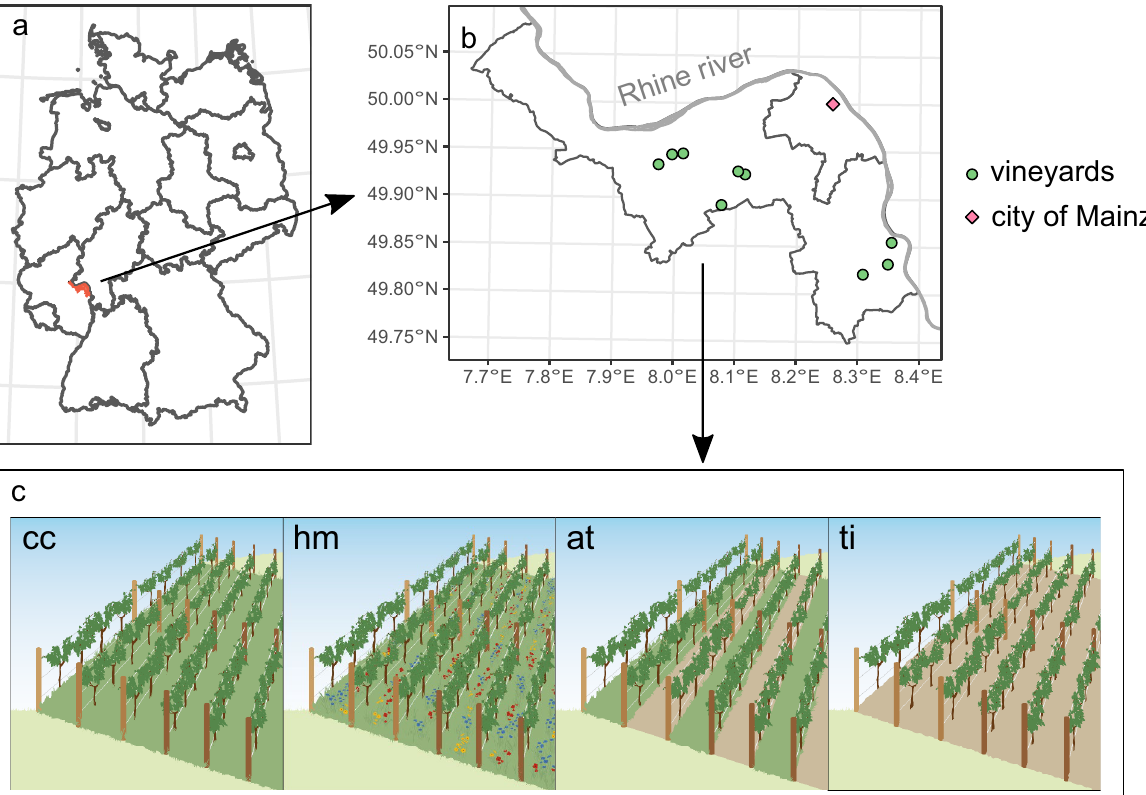
Figure 1. Location of experimental vineyards ( a , b ) and design of treatments ( c ). ( a ) Location of the study region (red shaded area) in Germany. ( b ) Experimental vineyards (green circles) were localized in the county ‘Mainz-Bingen’ close to the Rhine and the city of Mainz (purple diamond). ( c ) Illustration of soil treatments that were established in each experimental vineyard: ‘cc’: complete cover, ‘hm’: herbal mixture, ‘at’ alternating tillage, ‘ti’